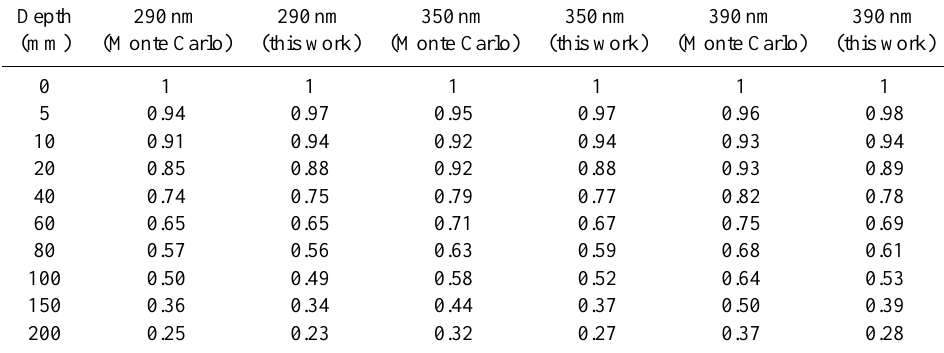
Table D3. Comparison of snowpack actinic flux profile for Summit, Greenland, using our parameterization and a Monte Carlo radiative transfer model (Peterson et al., 2002) for homogeneous snowpack with ρ snow =340kgm − 3 , snow grain diameter=0.25mm, C BC =0ngg − 1 , and diffuse sky conditions.